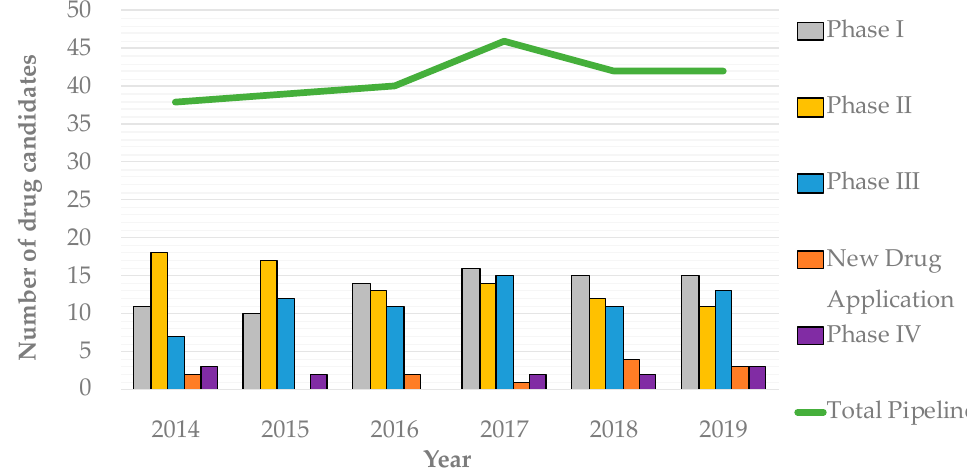
Figure 1. Evolution of the total antibiotic pipeline and the antibiotic pipeline by stage of development, which includes: Clinical Trials ranging from Phase I, to evaluate safety; Phase II, to access effectiveness and safety; Phase III, to gather statistically significant data on safety, effectiveness and benefits-versus-risk; submission of a New Drug Application, for marketing approval; and lastly, Phase IV for post-marketing surveillance.